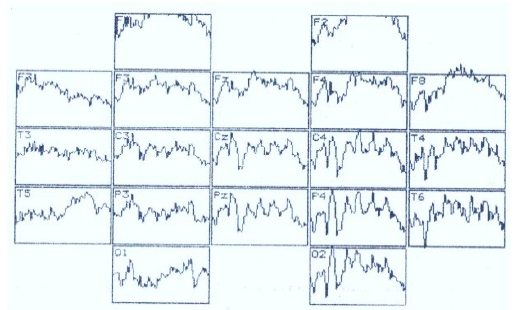
Figure 11. VEP distribution according to the 10–20 system in the perception of an identifiable visual image in a patient with left-sided ischemic stroke. Analysis time—1000 ms.